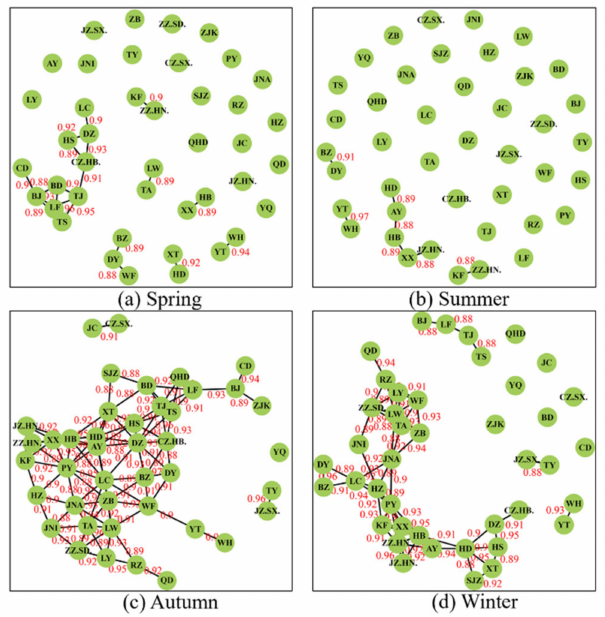
Figure 7. Network correlations between cities in different seasons ( a ): Spring, ( b ): Summer, ( c ): Autumn, ( d ): Winter, in the NNCP region ( ρ ≥